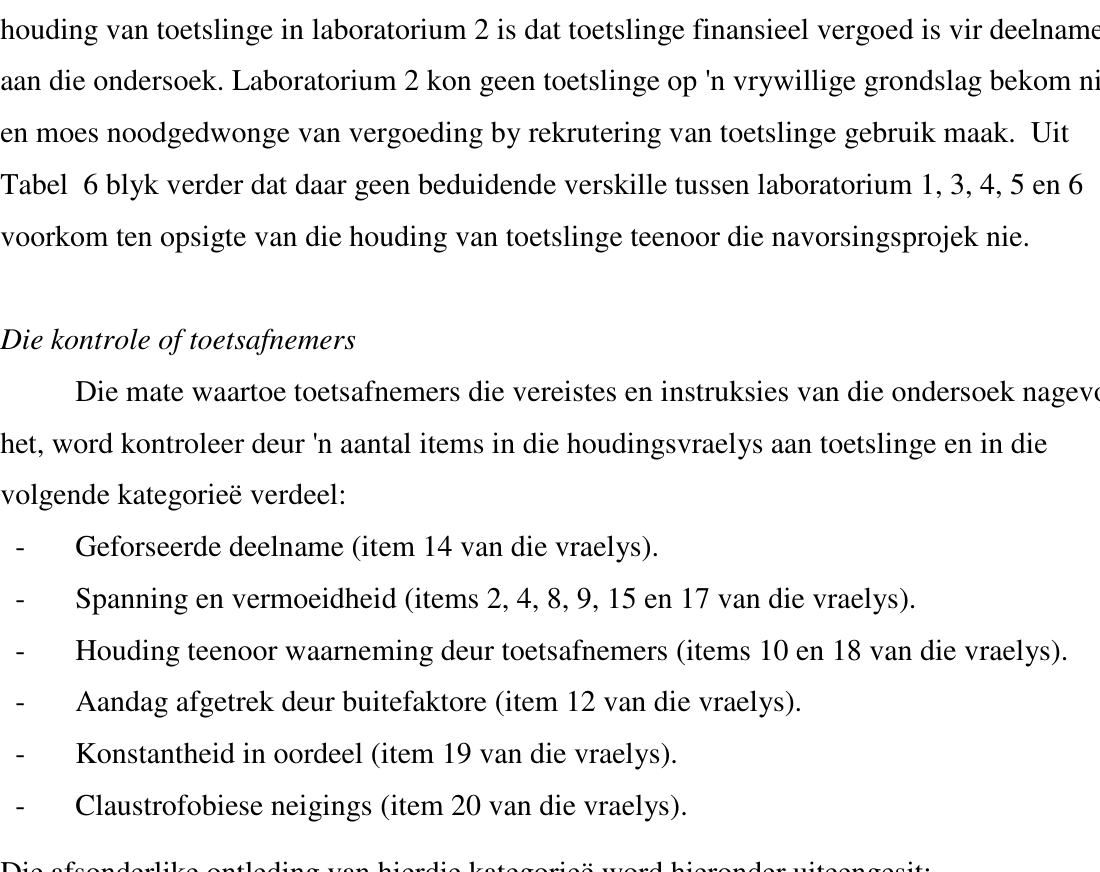
Uit Tabel 6 blyk dat die gemiddelde houding van toetslinge in laboratorium 2 beduidend verskil van laboratoriums 1, 3, 4 en 5 (p <,05) en ook beduidend verskil van laboratorium 6 (p <,01). 'n Moontlike verklaring vir hierdie beduidend minder positiewe houding van toetslinge in laboratorium 2 is dat toetslinge finansieel vergoed is vir deelname aan die ondersoek. Laboratorium 2 kon geen toetslinge op 'n vrywillige grondslag bekom nie, en moes noodgedwonge van vergoeding by rekrutering van toetslinge gebruik maak. Uit Tabel 6 blyk verder dat daar geen beduidende verskille tussen laboratorium 1, 3, 4, 5 en 6 voorkom ten opsigte van die houding van toetslinge teenoor die navorsingsprojek nie. Die kontrole of